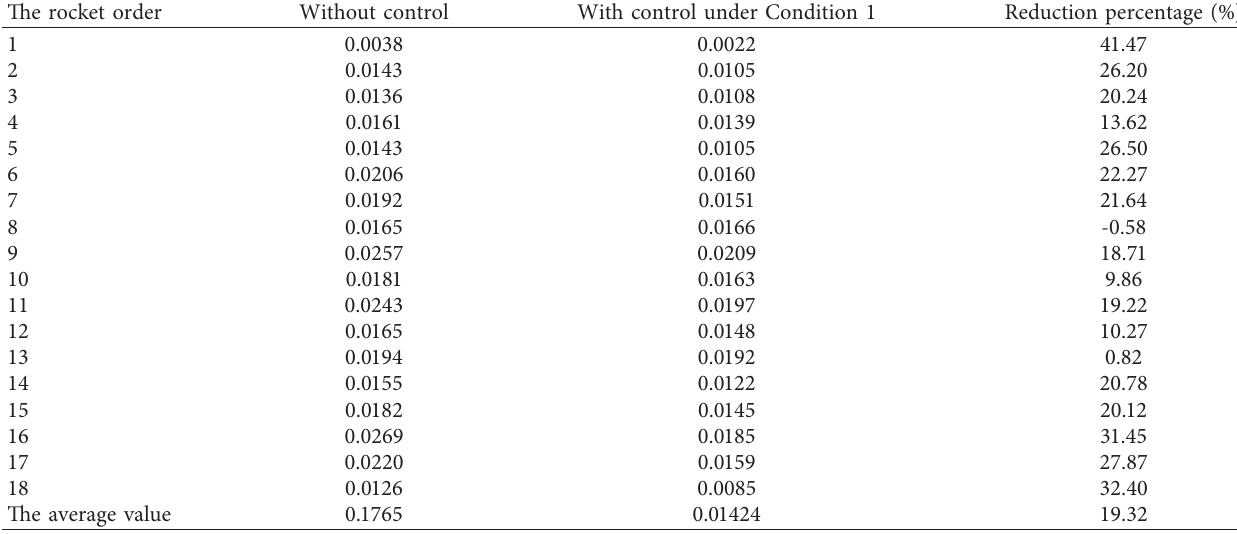
Table 1: Comparison of _ θ yz in the control period under Condition 1.